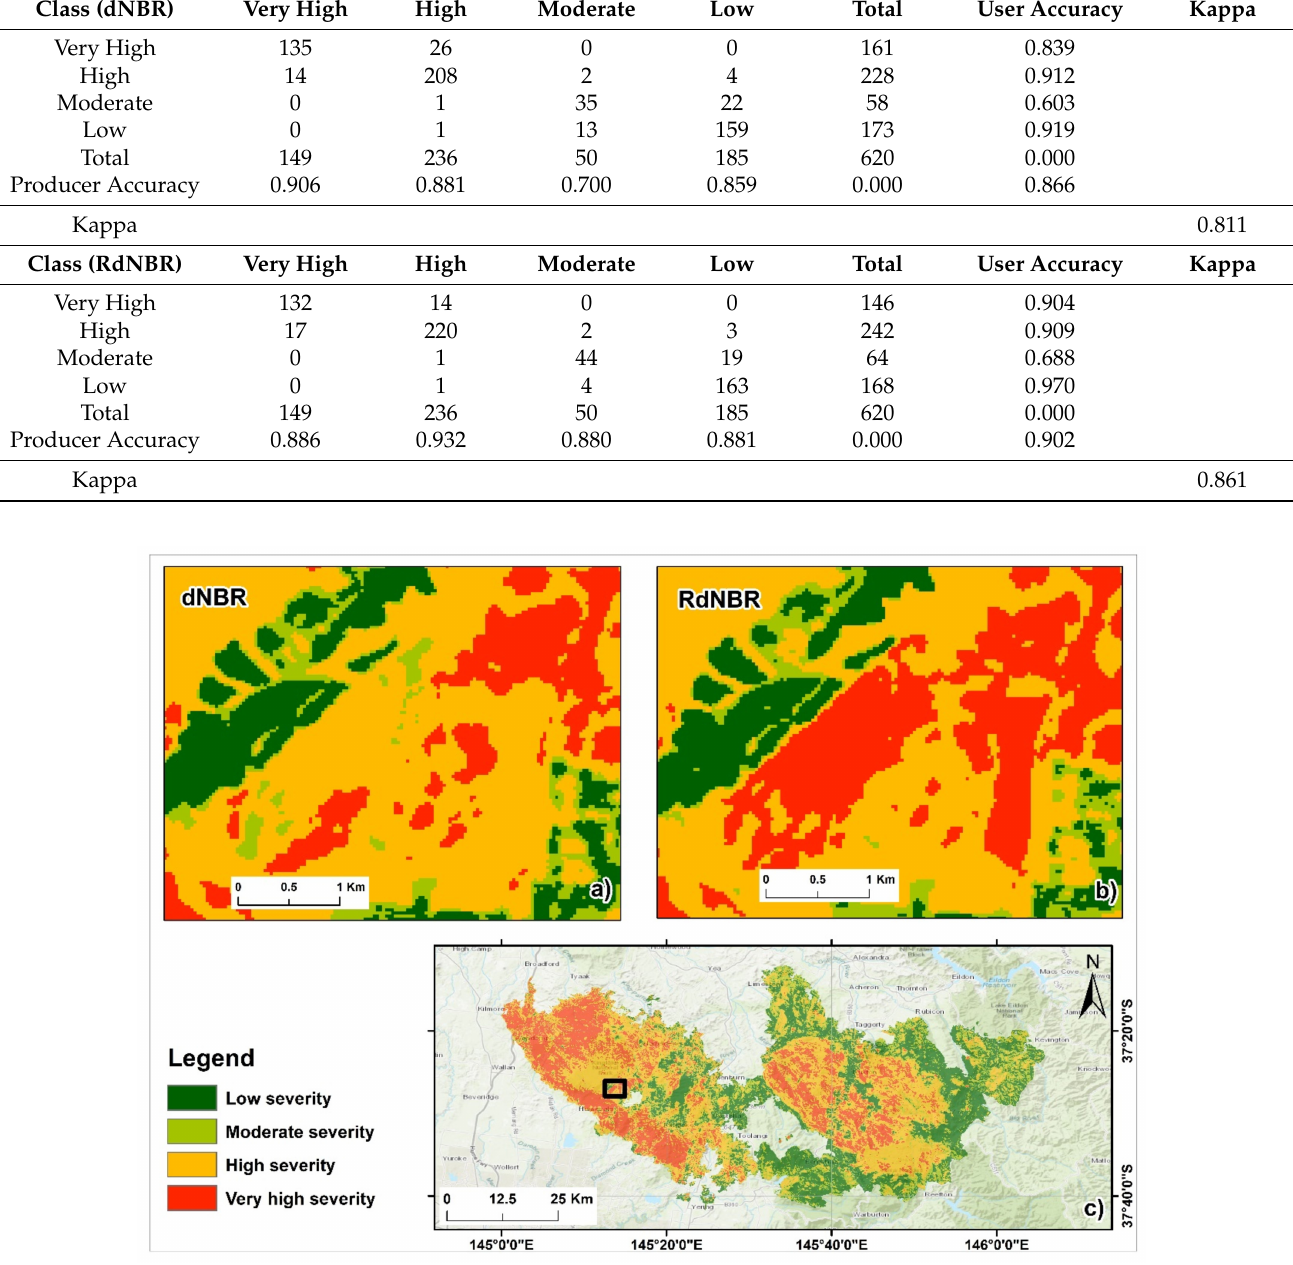
Figure 6. An example of variation in ( a ) dNBR and ( b ) RdNBR indices in a heterogenous landscape. Unlike dNBR, RdNBR shows very high severity in the highlighted area (black rectangle in map) ( c ). The ground truth plot data in the region support the results obtained from RdNBR